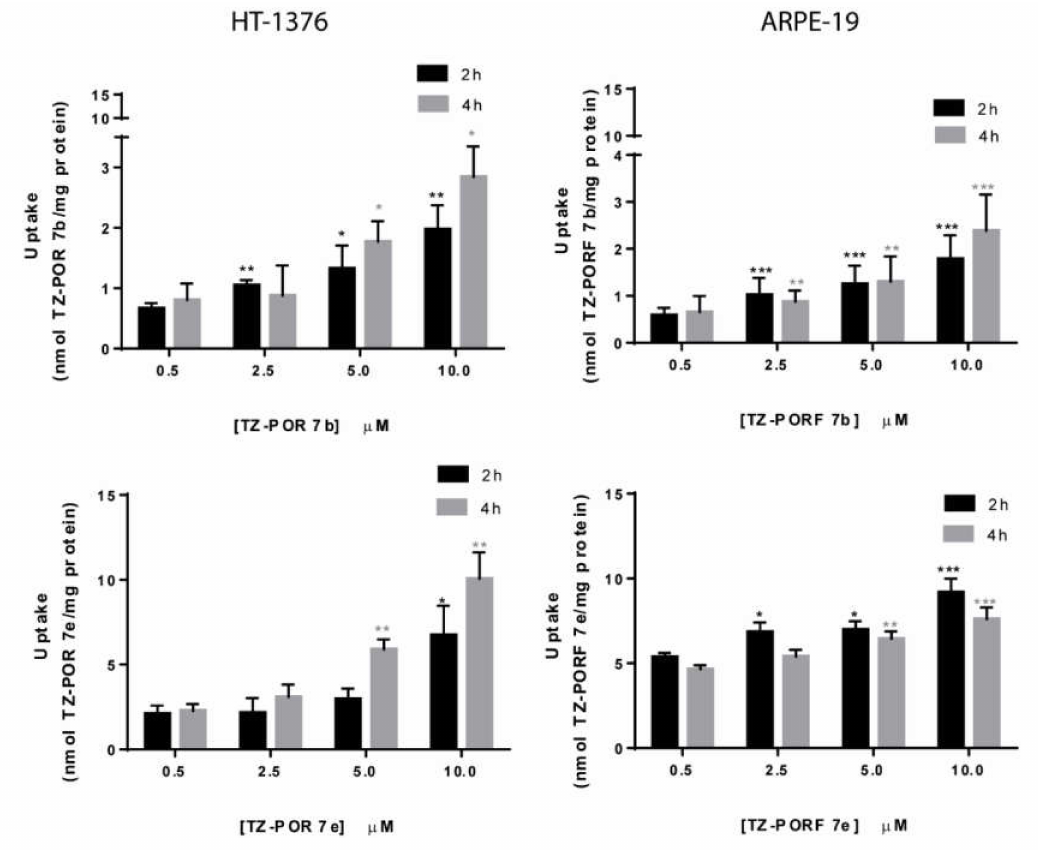
Figure 3. Intracellular uptake of PVP-TZ-POR 7b and 7e by HT-1376 and ARPE-19 cells. Data are the mean ± S.D. of at least three independent experiments performed in triplicates: *( p < 0.05), **( p < 0.01), ***( p < 0.001) significantly di ff erent from uptake of PSs at lower